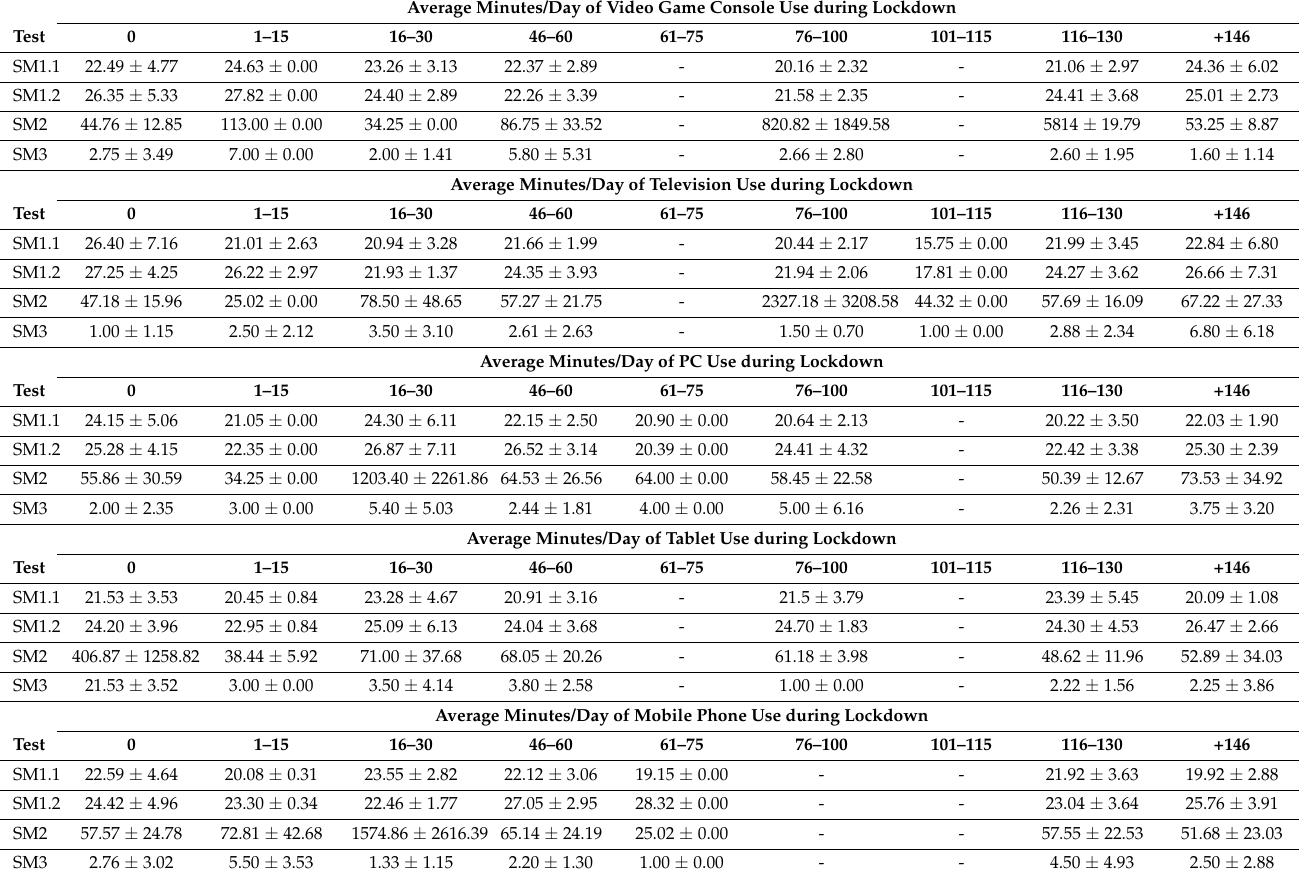
Table 3. The post-lockdown manual dexterity test results according to exposure to screens during lockdown using descriptive